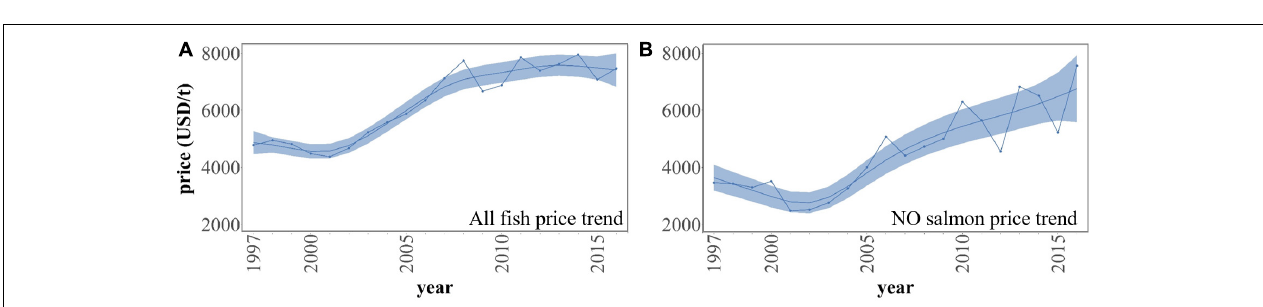
FIGURE 6 | Historical price trends for overall fish prices (A) , and Norwegian salmon (B) for the respective available historical data coverage (line with dots) in USD/ton with the generalized additive model (GAM) fit (solid line) and the 95% confidence interval corresponding to the predicted standard error of the model fit (shade). Data sources: FAO Fishery and Aquaculture Commodities statistics (fish price), NQSALMON, 2020 (salmon